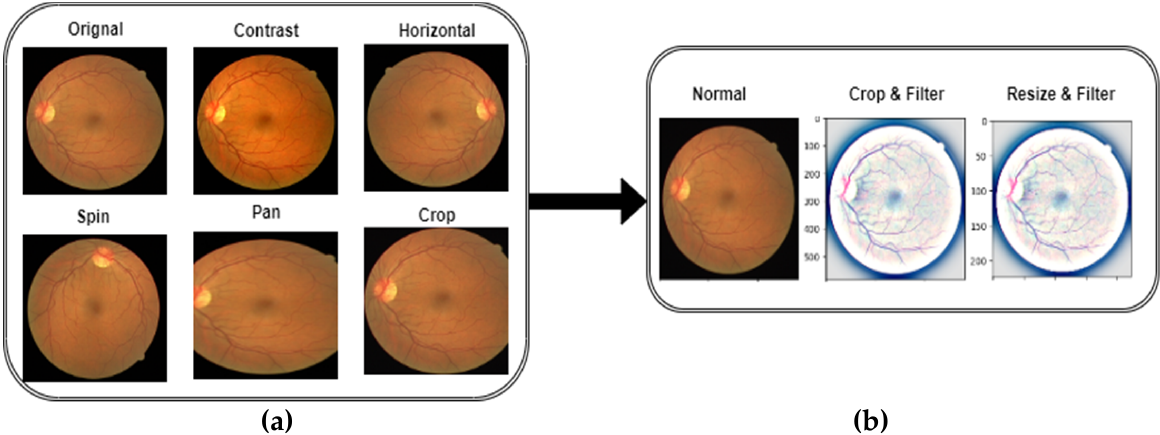
Figure 5. A visual diagram of the preprocessing steps to apply the ( a ) data augmentation techniques and ( b ) enhance the HR-related lesions.